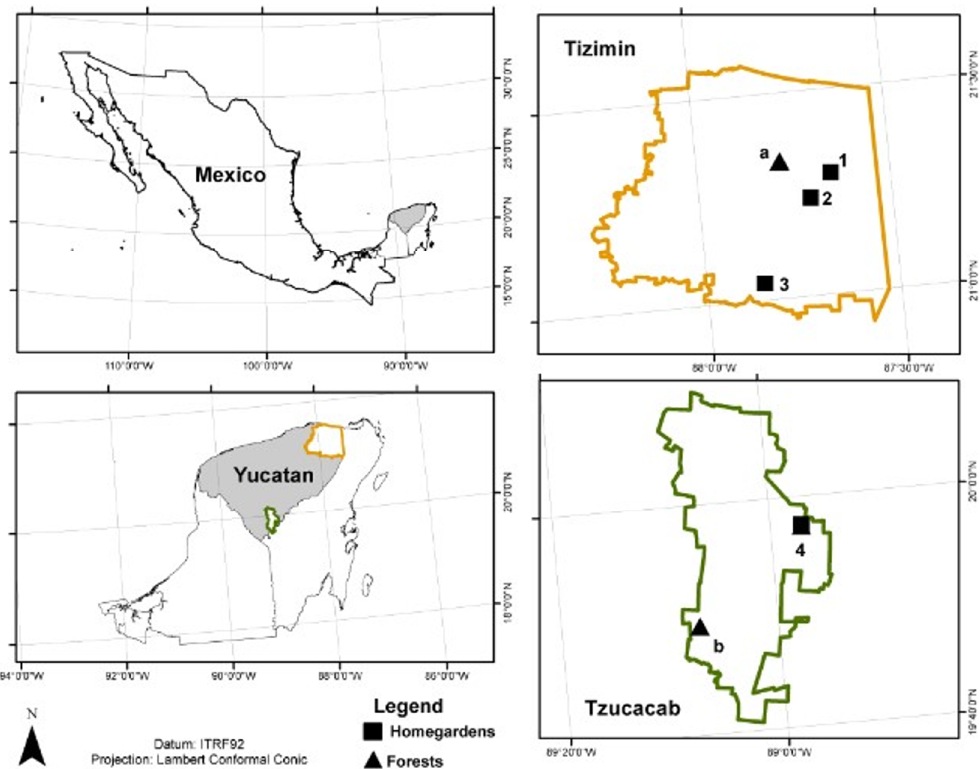
Figure 9. Geographic location of Cordia dodecandra populations from ( a , b ) forests and ( 1 – 4 ) homegardensin the ( a , 1 – 3 ) Northeast region (Tizimín municipality) and ( b , 4 ) Southwest region (Tzucacab municipality).